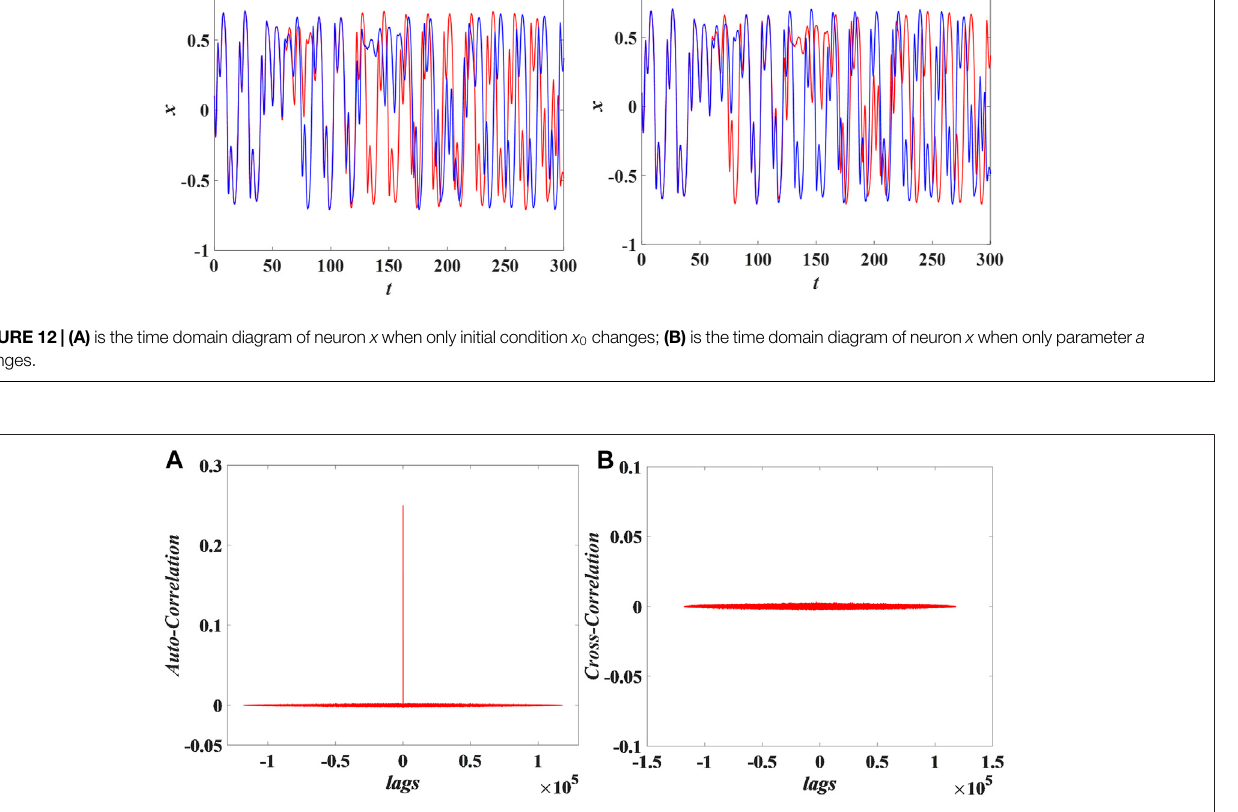
FIGURE 13 | Correlation analysis of 15 sequences for PRNG: (A) Auto-correlation, (B) Cross-correlation.